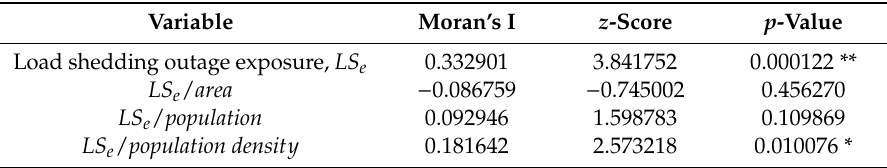
Table 5. Global Moran’s I result for load-shedding exposure